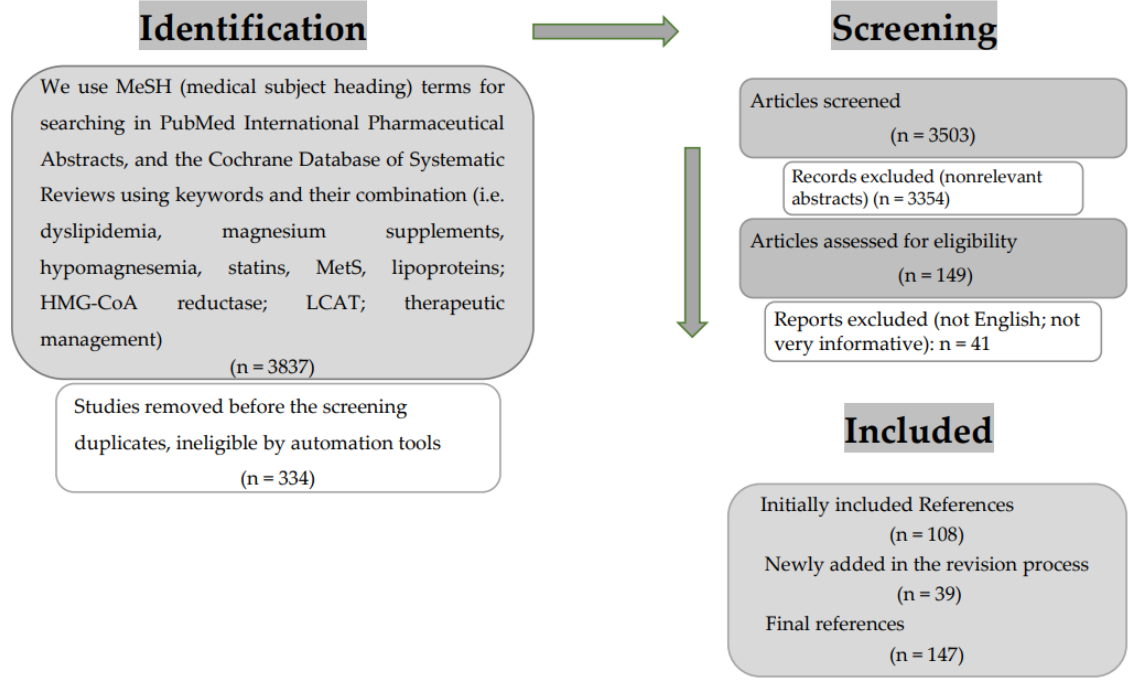
Figure 1. Studies identified via databases and registers.